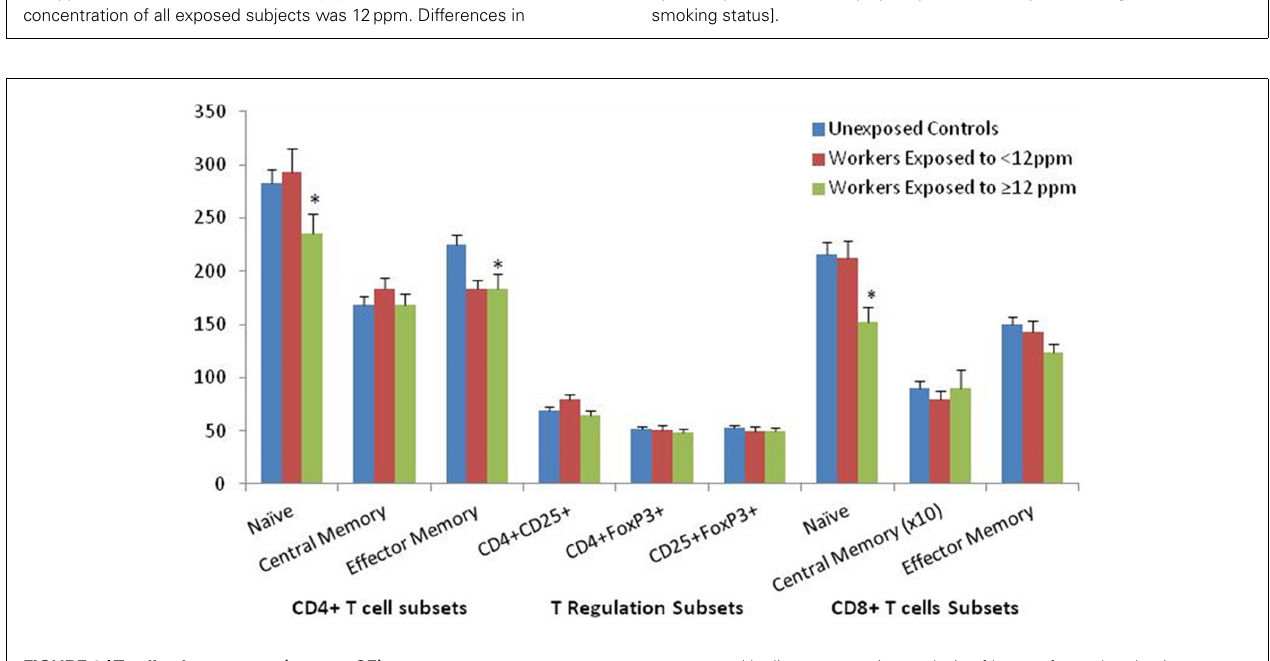
cell counts were tested by linear regression analysis of FIGURE 1 | Lymphocyte and lymphocyte subset counts ln-transformed end point, adjusting for relevant covariates [lymphocytes: (mean ± SE) among trichloroethylene (TCE) exposed workers adjusted for age and sex; CD4 + , CD8 + , and NKT cells: adjusted for age and and unexposed controls. Results previously reported in (Lan et al., 2010). Lymphocytes and lymphocyte subset counts in relation toTCE sex, three subjects (two controls and one exposed) were deleted due to exposure level. P trend using category ofTCE levels (controls, < 12 and inconsistent cell counts using complete blood count data versus flow ≥ 12ppm) as a continuous variable (* P < 0.05).The medianTCE cytometry to calculate % lymphocytes; B cell: adjusted for age, sex, and trend smoking status]. concentration of all exposed subjects was 12ppm. Differences in